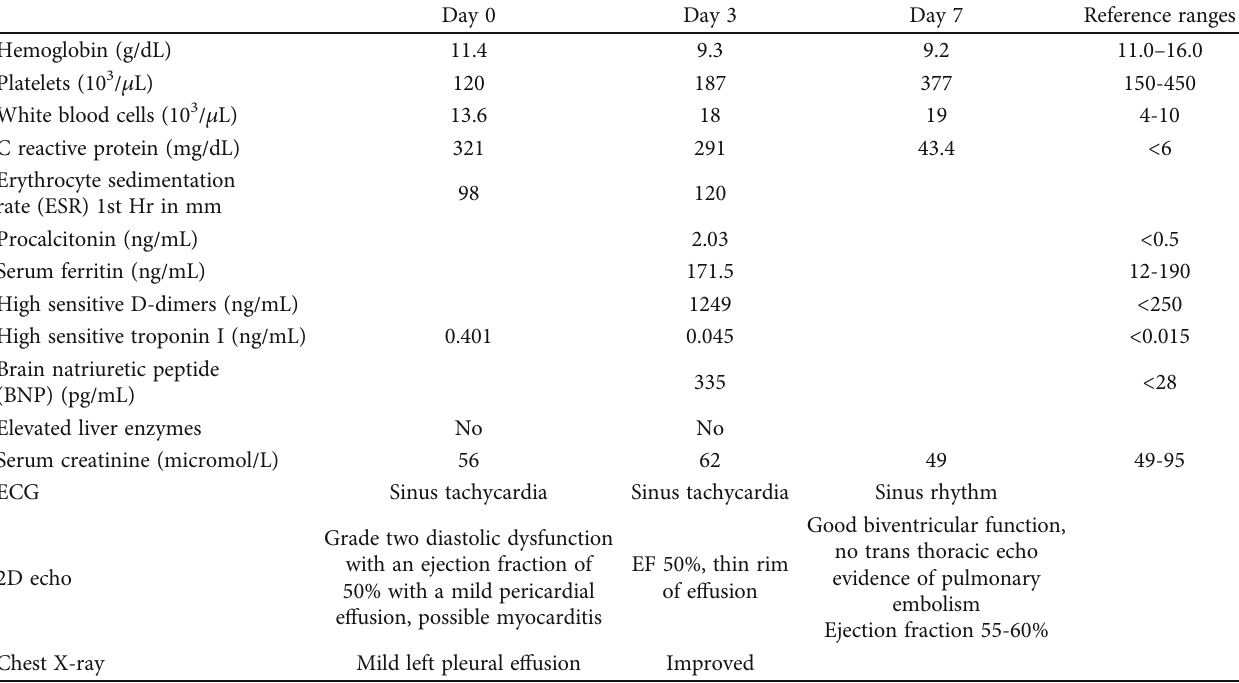
Table 1: Summary of